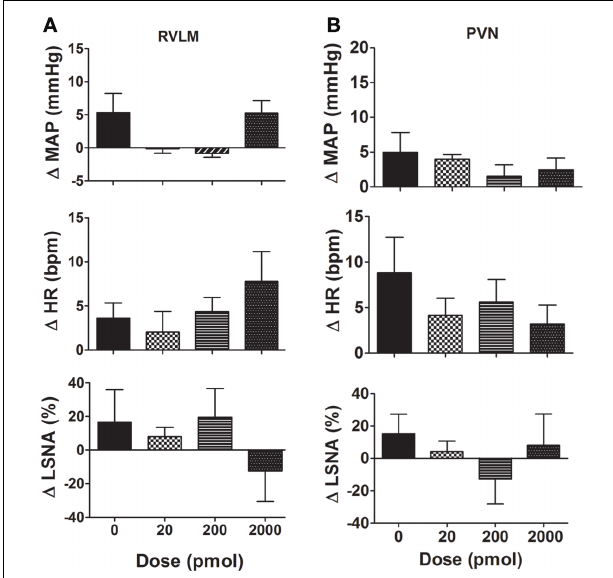
FIGURE 5 | (A) Changes in mean arterial pressure (MAP), heart rate (HR), and lumbar sympathetic nerve activity (LSNA) following vehicle and the H 2 S donor (NaHS, 20–2000pmol/side; n = 3) microinjected into the rostral ventrolateral medulla (RVLM) of SHR rats. Different shaded bars represent a different dose of NaHS as indicated. (B) Changes in mean arterial pressure (MAP), heart rate (HR), and lumbar sympathetic nerve activity (LSNA) following vehicle and the H 2 S donor, NaHS (20–2000pmol/side; n = 5) microinjected into the hypothalamic paraventricular nucleus (PVN) in SHR rats. Different shaded bars represent a different dose of NaHS as